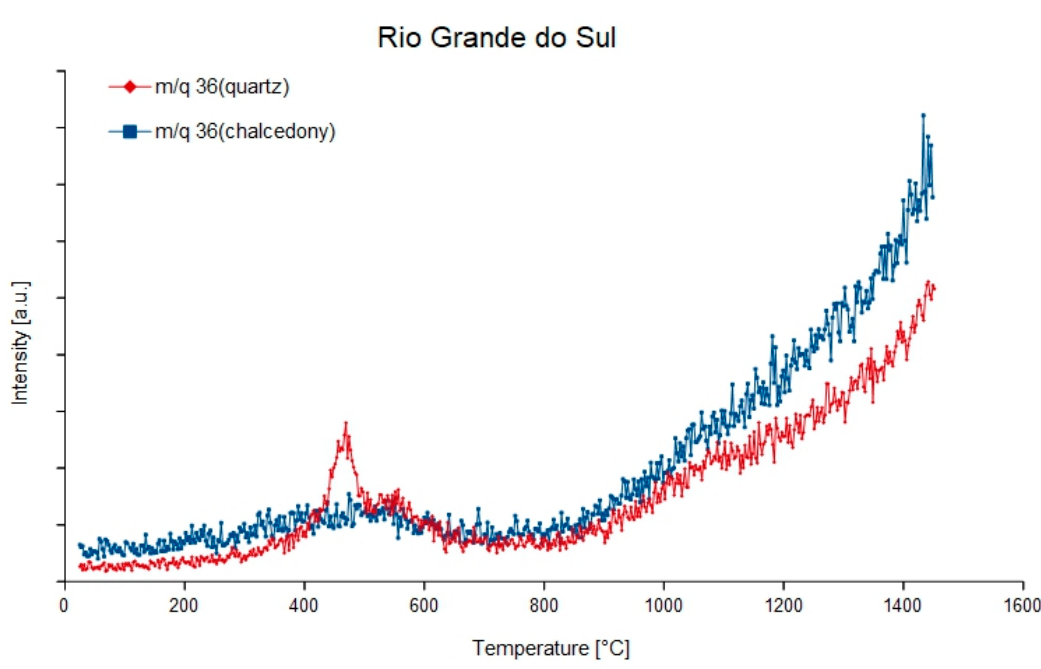
Figure 4. Degassing curves of the mass-charge ratio 36 ( 1 H 35 Cl) of quartz and chalcedony in agate from Rio Grande do Sul, Brazil.